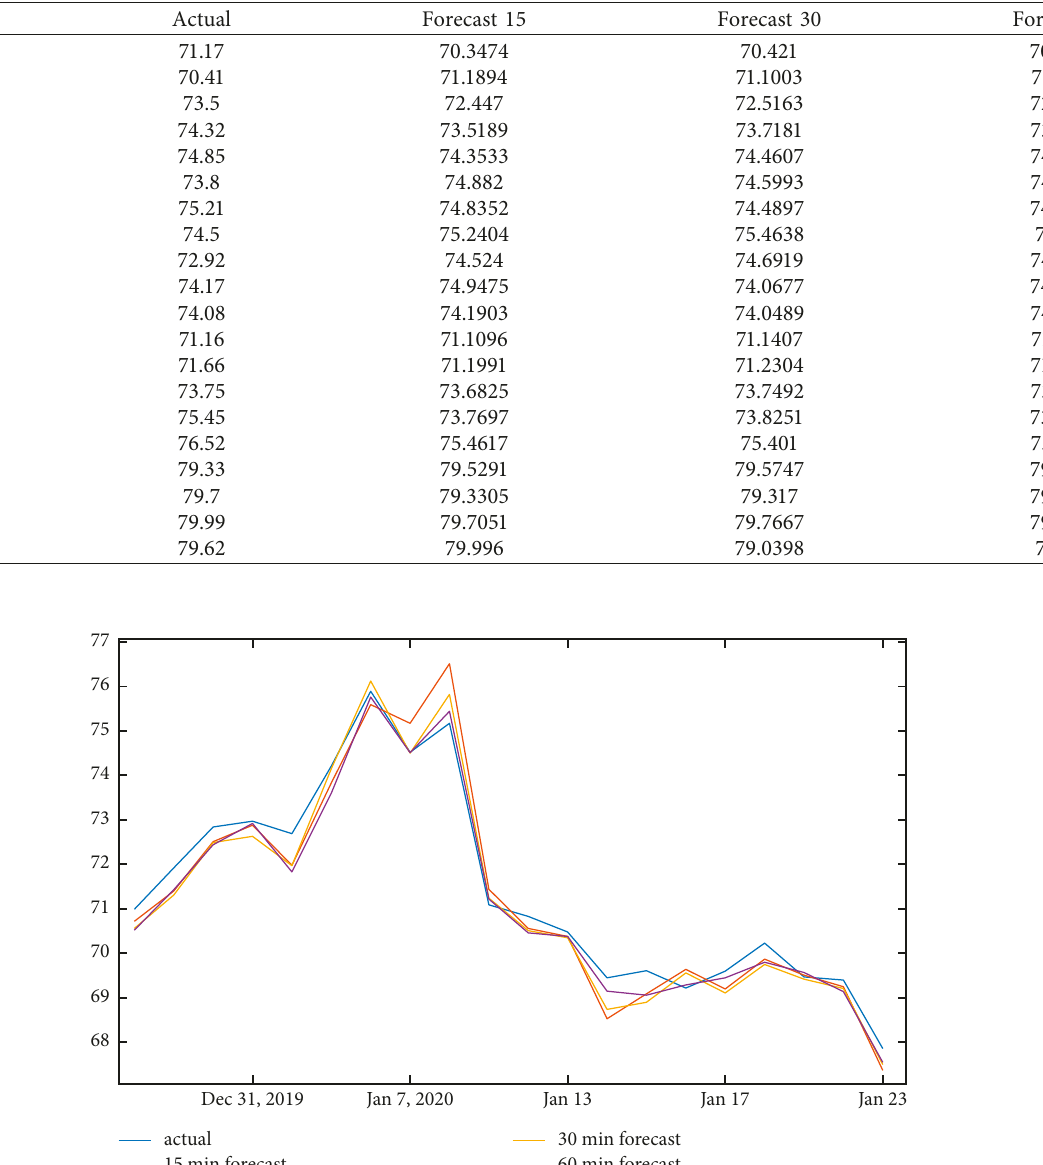
Table 4: Actual and forecast price (USD per barrel) in different frequencies without night trading (after May,